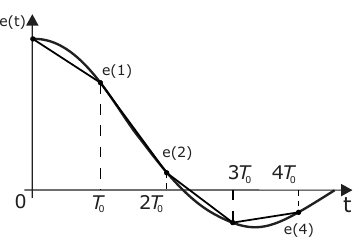
Figure 6. Block diagram of a control system [22].